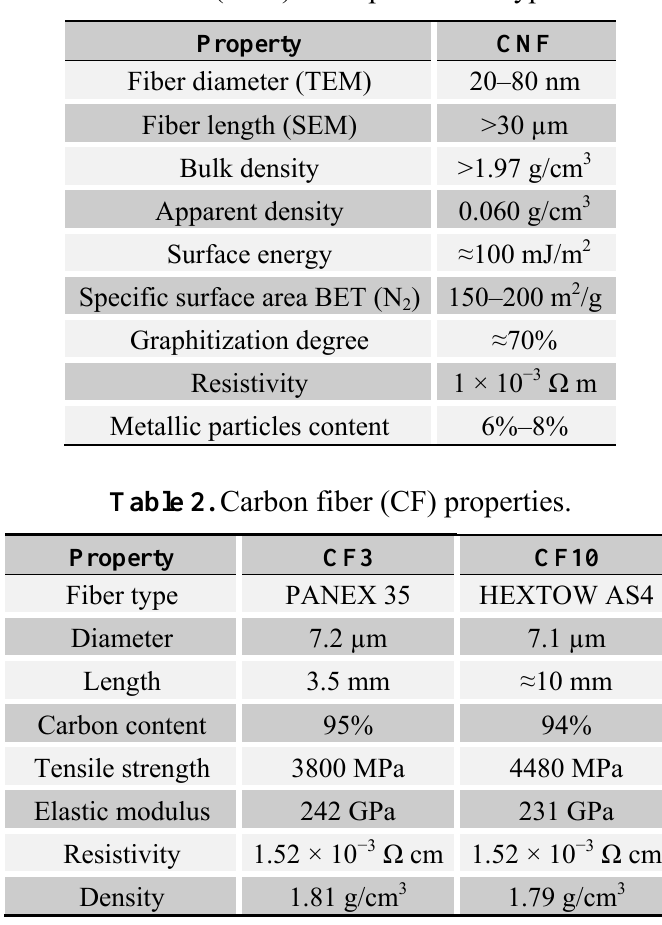
Table 1. Carbon nanofiber (CNF)—Grupo Antolín type GANF4 properties.